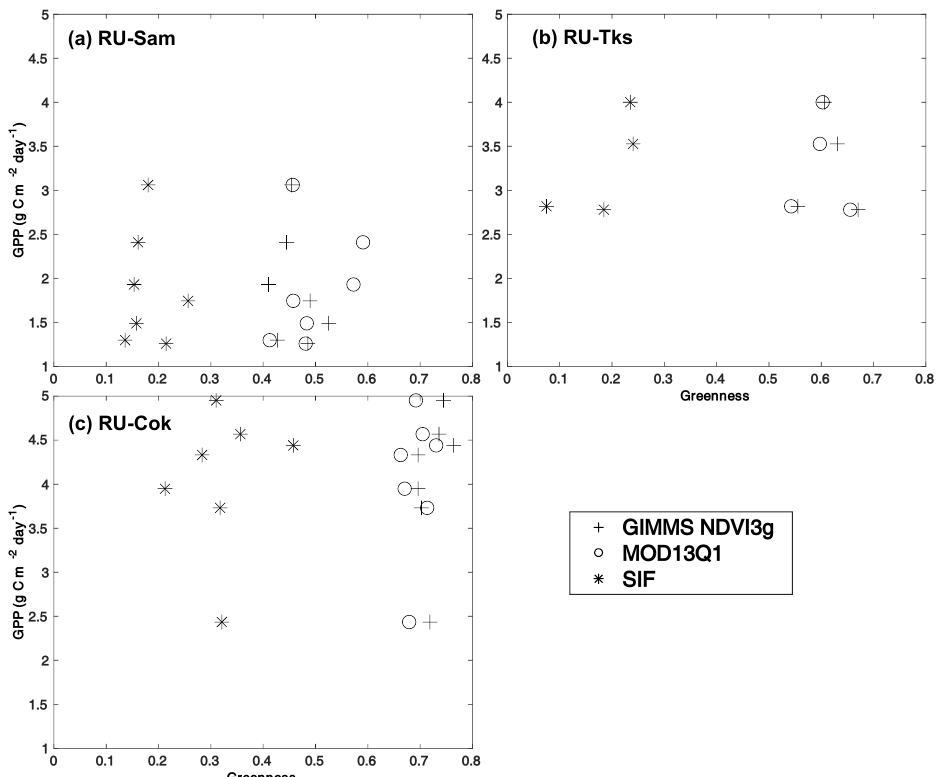
Figure 4. Comparison between the tundra greenness (GIMMS NDVI3g, MOD13Q1 and SIF) and the maximum value of monthly GPP derived from ( a ) RU-Sam, ( b ) RU-Tks, and ( c ) RU-Cok. The greenness was calculated as the 3 pixel × 3 pixel average value around the EC flux tower for each year. For more details about EC flux sites, see Table 2. Table 3. Statistical comparison of greenness (GIMMS NDVI3g, MOD13Q1, and SIF) with the three